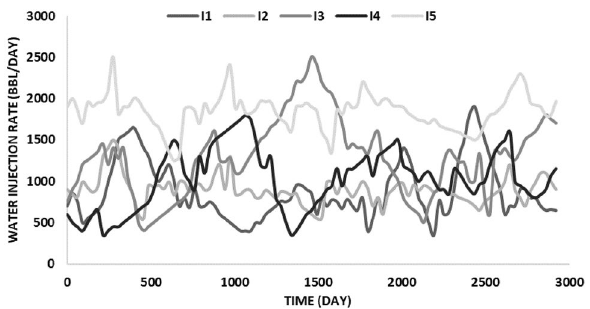
Fig. 4 An example of liquid injection rates in cases I and II. I 1 stands for injector 1 and others are represented with the same naming con- vention